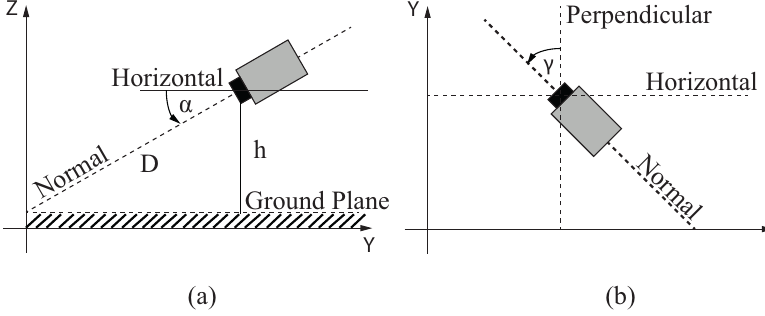
Figure 1. Camera model used in this work. ( a ) View of the Y-Z plane for height and tilt; ( b ) View of the X-Y